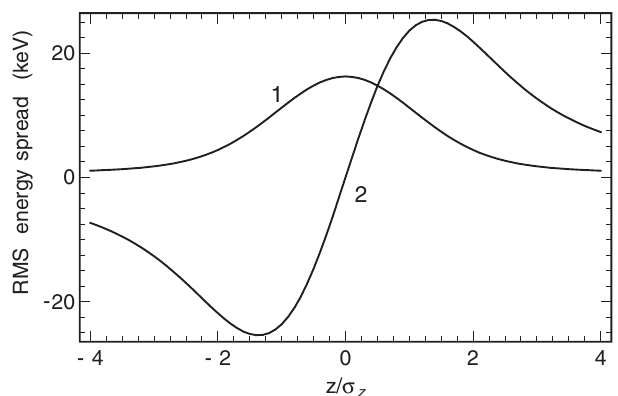
FIG. 4. Energy loss induced by the acceleration field (averaged over transverse dimensions) as a function of electron longitudi- nal position, curve 1. For comparison, we also show the energy loss introduced by the space charge effect, curve 2.